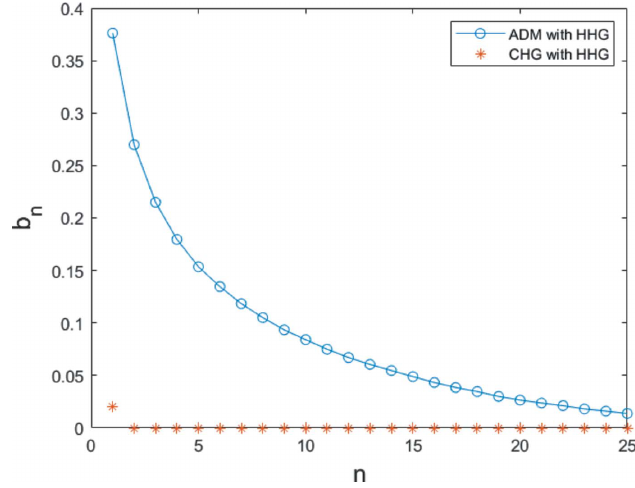
Figure 4 Comparison between the bunching factors of ADM and CHG with HHG as the seed